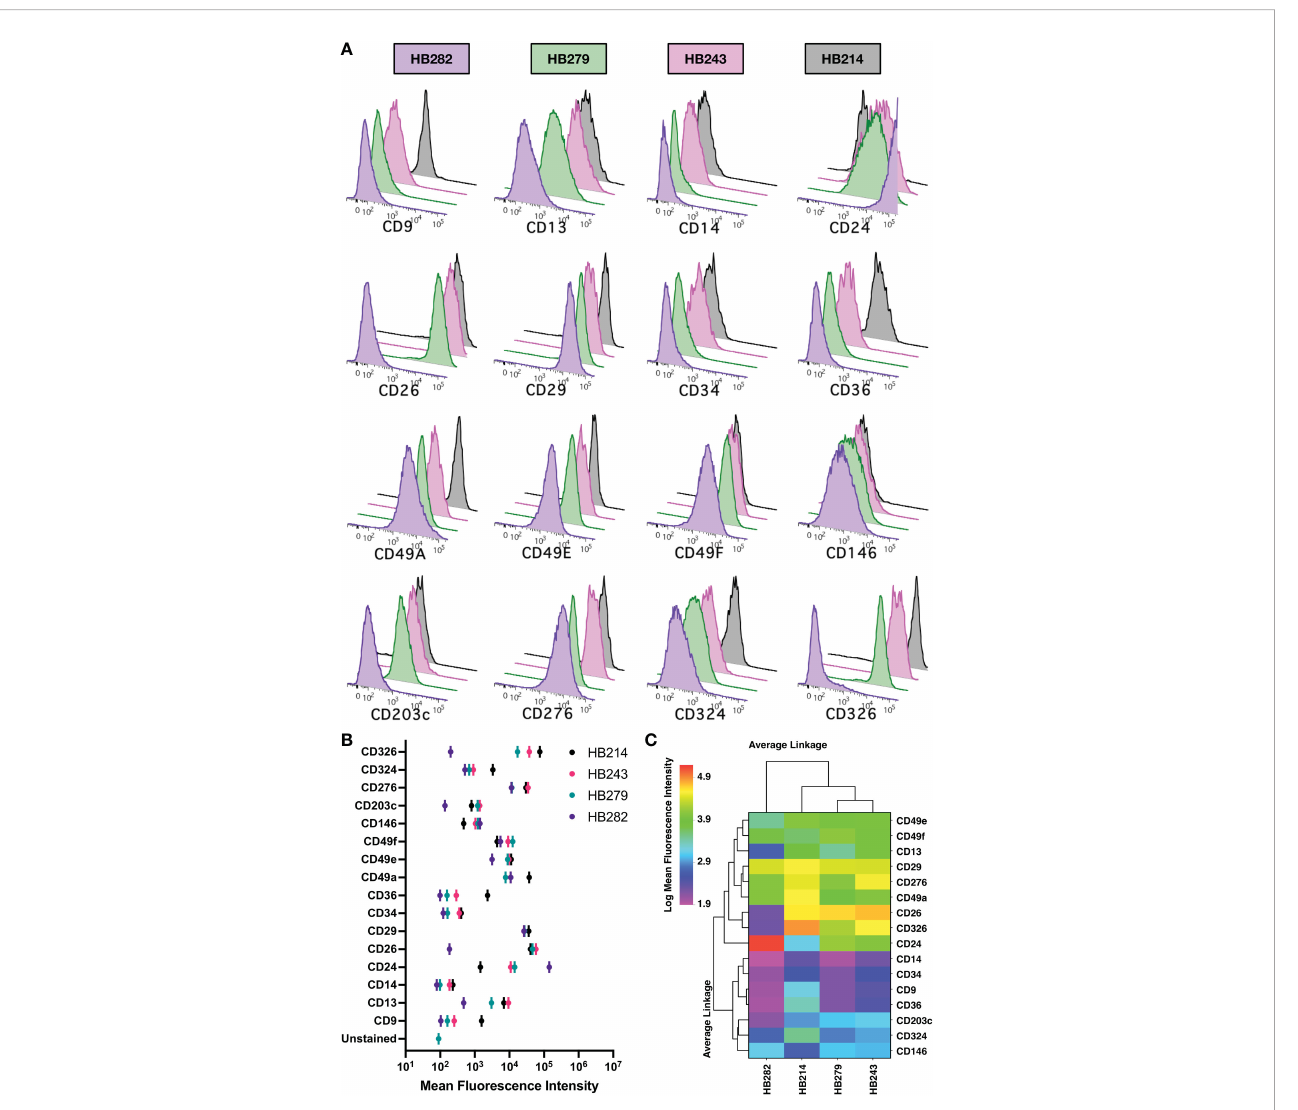
FIGURE 7 Marker expression on hepatoblastoma cell lines. (A) Expression of 16 markers were analyzed by fl ow cytometry on 4 cell lines and the relative expression data shown as histograms in overlay plots for each marker. (B) Mean fl uorescence intensities of each marker are compared for each cell line. (C) The expression of the markers on cell lines is shown as a heat map ordered based on clustering using an unweighted pair-group method using arithmetic averages and Euclidian distancing. A log transformation of the mean fl uorescence intensity data was performed prior to analysis to better resolve the data on the linear scale used to show heat map